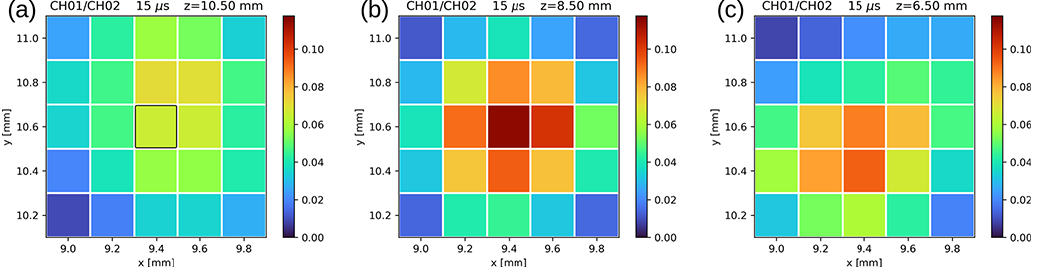
Figure 11. Signal mapping of the first session (13 January 2021) showing the normalized signal for three planes at different z positions and chosen range (15µs – 2250ma.g.l.). The position derived from the manual alignment is highlighted by the black